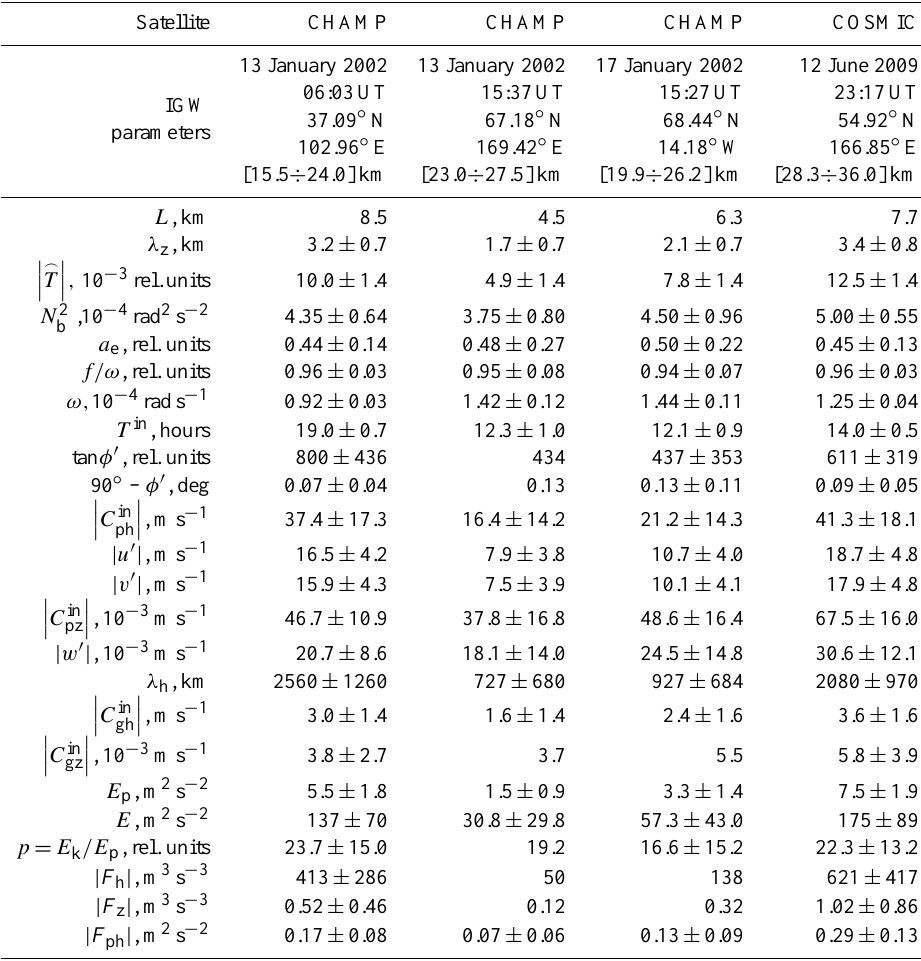
Table 2. Wave parameters found from CHAMP & COSMIC GPS radio occultation retrievals of temperature profiles in four regions of the Earth’s atmosphere. The coordinates of sounded regions, time and altitude intervals of observations are indicated. Uncertainties of determined parameters are also shown when they are less than